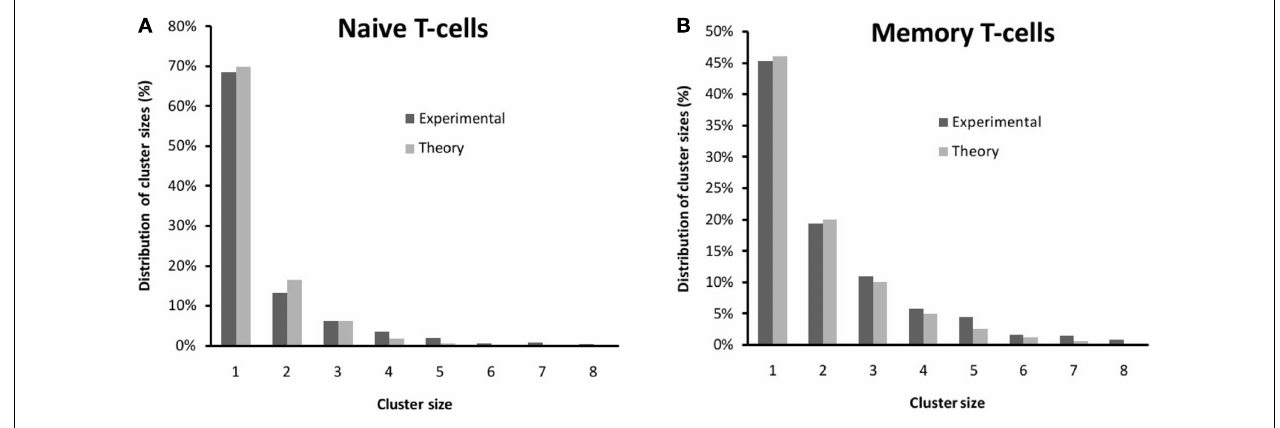
fitted to equation (2) using a weighted (by the variance) minimum-square regression.The fitted values are b naive = 0.32 and b memory = 0.55.